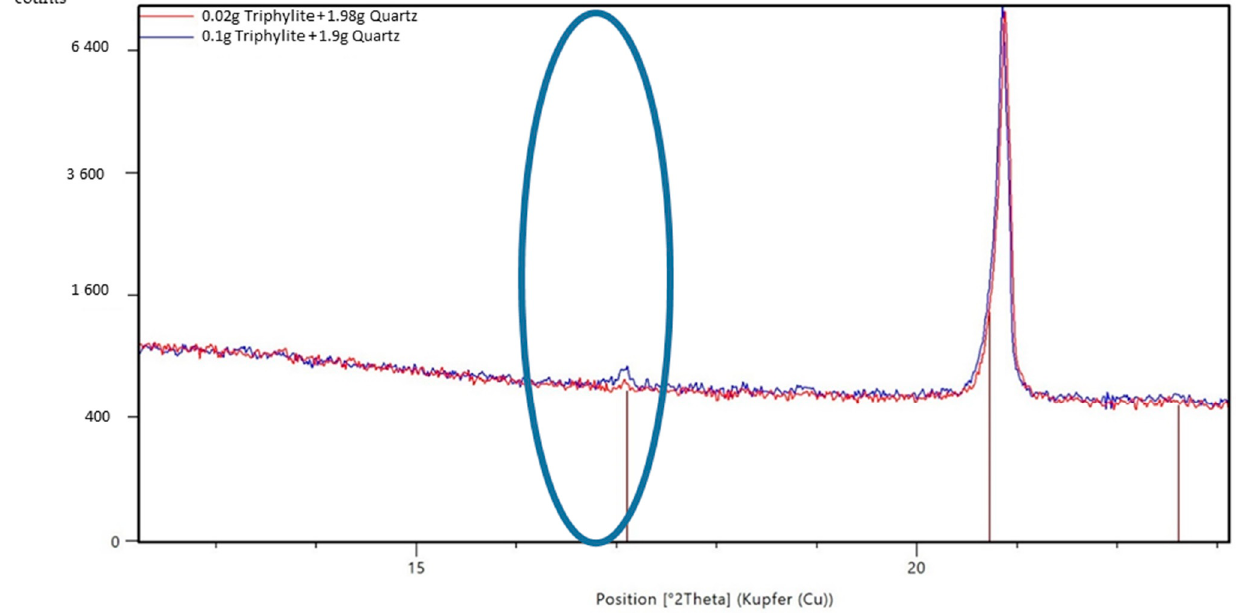
Figure 13. XRD pattern of small additions of triphylite to quartz matrix (1% Triphylite/99% Quartz).